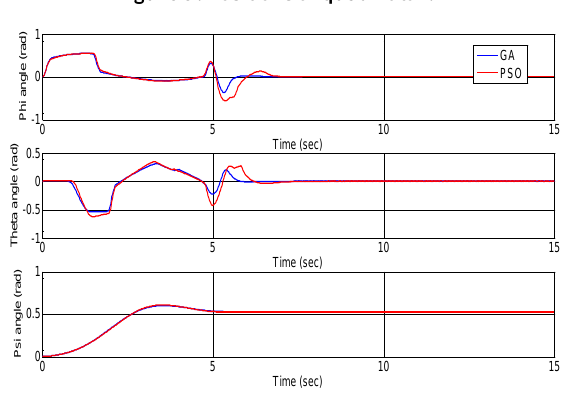
Figure 9. Positions of quad rotor.